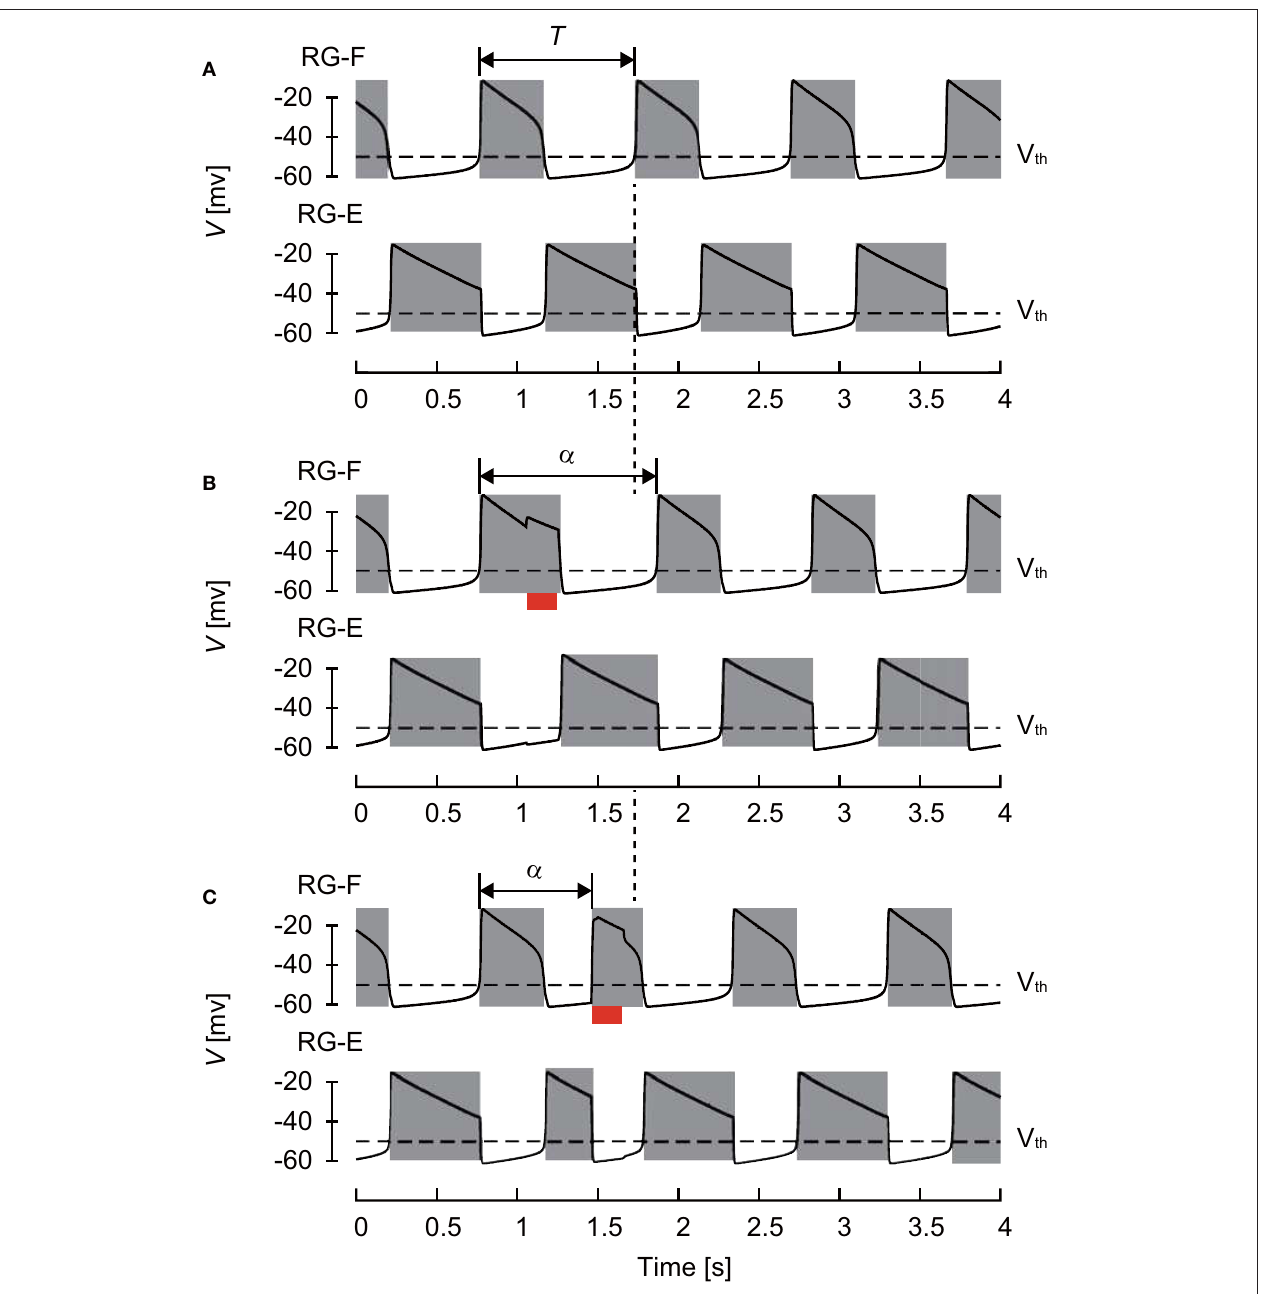
FIGURE 2 | Changes of membrane potential of RG-F (top panel) and RG-E (bottom panel) neurons (A) without any stimulation, (B) with stimulation applied to the flexor side during flexor phase, and (C) with stimulation applied to the flexor side during extensor phase. The red bars indicate the application of stimulation. Gray regions indicate active phases. The applied stimulation increased the duration of the current flexor phase and cycle period in (B) and initiated the flexor phase and decreased the cycle period in (C) . Both stimulations produced phase shifts. stimulation was applied during the silent phase of RG-F